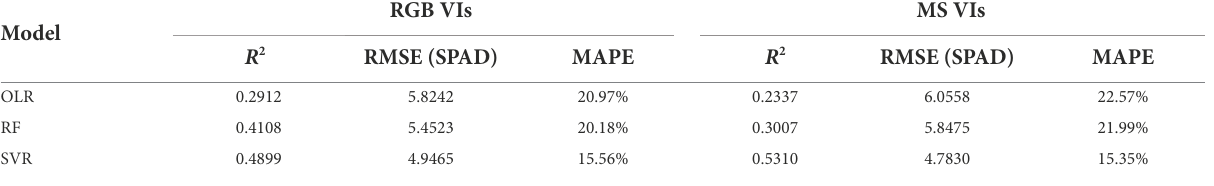
Figure 6 indicates that the fitting effects of RF and SVR with the shade variables were significantly better than those of the models without the shade variables (Figure 5) irrespective of RGB or MS images. According to the R 2 , RMSE, and MAPE, the order of RGB-based and MS-based model accuracy was RF > SVR > LMM > OLR. For the optimal RF model, R 2 based on RGB and MS VIs reached 0.9273 and 0.9389, respectively. The R 2 value of the SVR model with the next highest goodness of fit reached 0.8651 and 0.8595, while the R 2 values of the LMM and OLR models were lower than 0.8. A comparison of the interpretation ability of RGB and MS VIs under the same algorithm indicated that MS VIs were